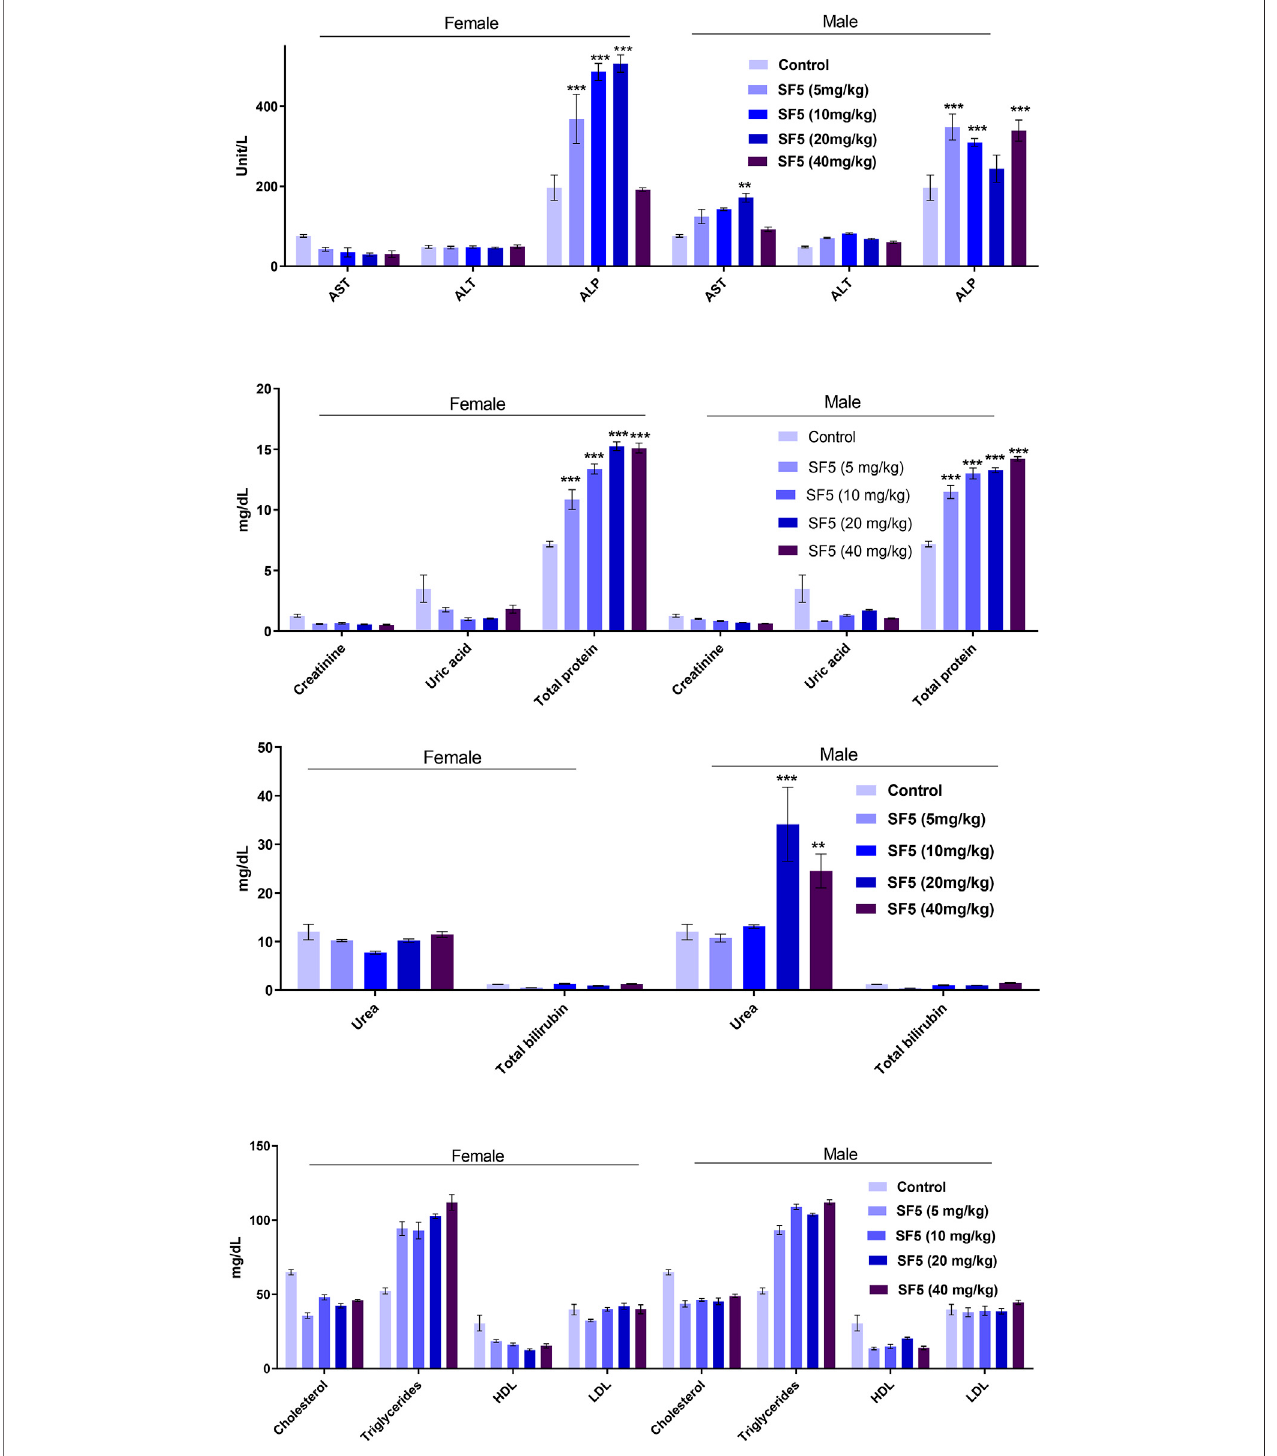
FIGURE5| Effect ofSF5 treatment on liverfunction,kidneyfunction, and lipidpro fi le inboth males and femalesat different doselevels. ** p < 0.01 and*** p < 0.001 given in comparison to the control.